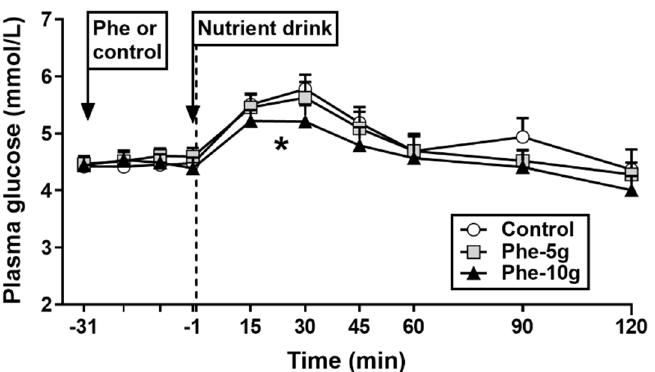
Figure 4. Plasma concentrations of glucose at baseline (t = 31 min), in response to an intragastric bolus (100 mL) of phenylalanine, at doses of either 5 g (‘Phe-5 g) or 10 g (‘Phe-10 g), or control (t = − 20, − 10, − 1 min), and after a mixed-nutrient drink (t = 15–120 min). Dotted line represents the time at which consumption of the drink was complete. Data were analysed using a mixed models analysis including baseline as a covariate and treatment as a fixed factor. Post hoc comparisons, adjusted for multiple comparisons by Bonferroni’s correction, were conducted when the mixed model revealed significant effects. Glucose AUC − 1 to 120 min : * Phe-10 g significantly different from control ( P = 0.043). Data are means ± SEM; n = 16.